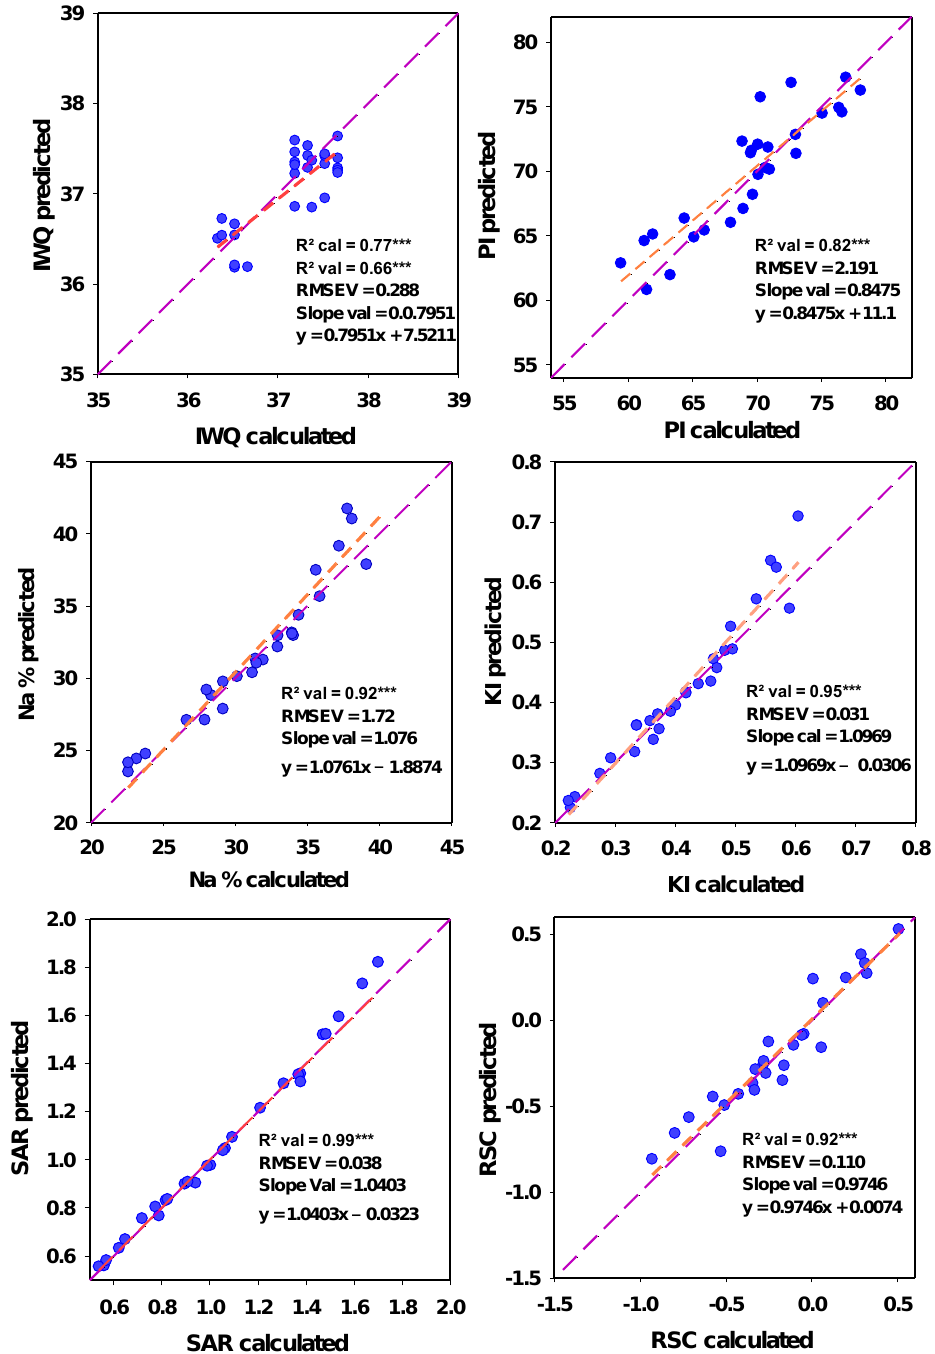
Figure 10. The validation models of relationships between observed against predicted for the six Water Quality Indices (WQIs) based on the Principal Component Regression